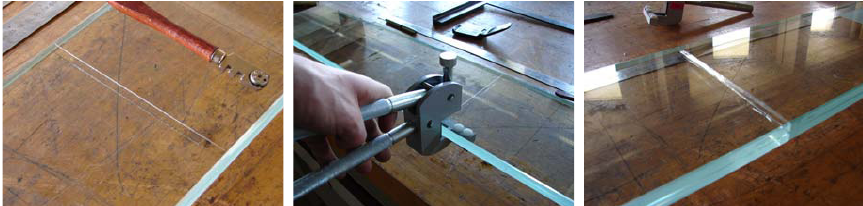
Figure 1: Making initial cracks : scratching the surface / cracking a glass plate / resulting initial cracks